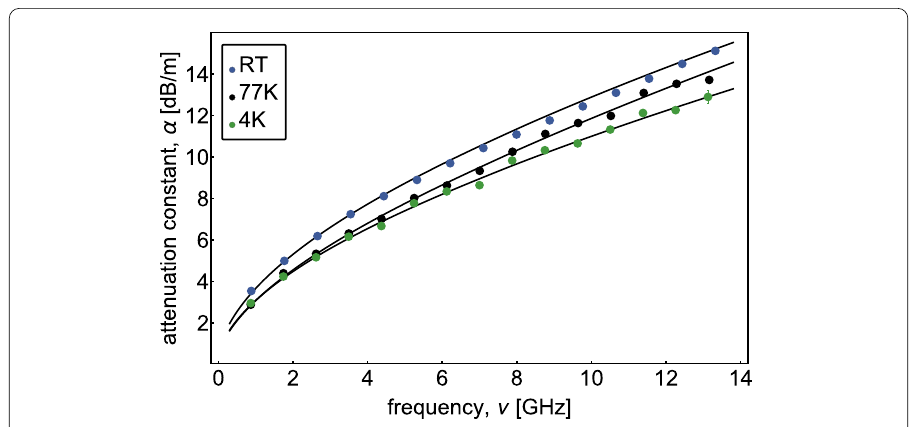
Figure 8 Frequency and temperature dependence of attenuation constant of stainless steel coaxial line CC085SS. Measured attenuation constant α (dots) versus frequency ν for a CC085SS at RT, approximately 77 K (LN2), 4 K (LHe). The black lines are calculated from fits to the measured Q i using the model of Eq. (5) as described in the main